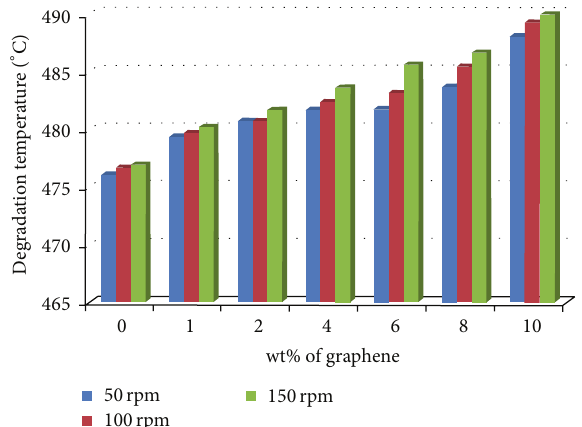
Figure 9: Effect of % of graphene on degradation temperatures of LLDPE/C-GNPs composites at different screw/feeder